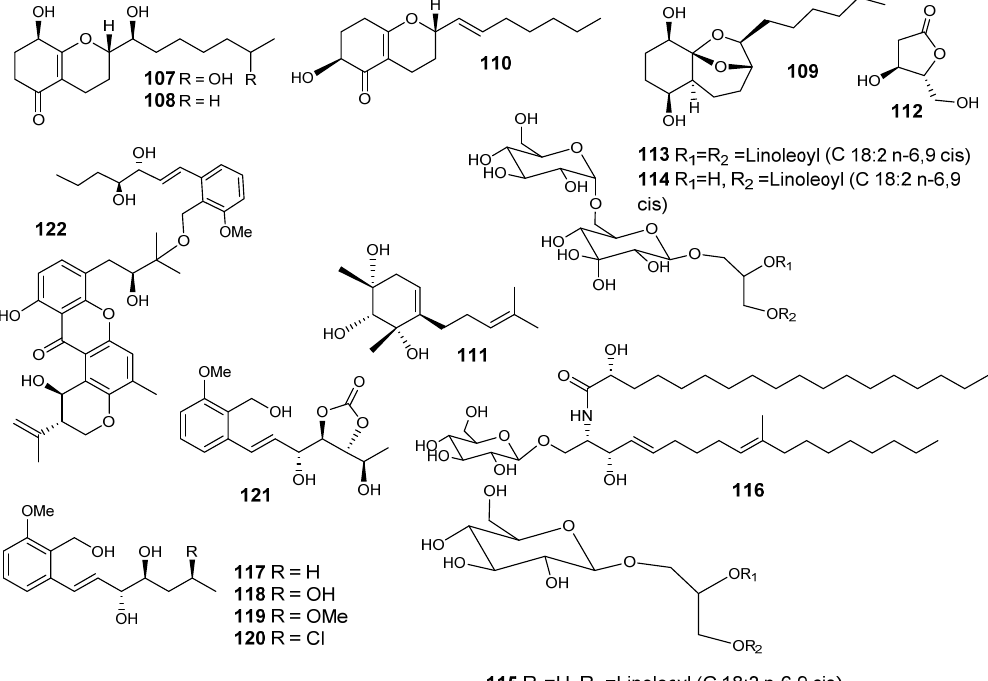
Figure 7. Structures of compounds 107–122.